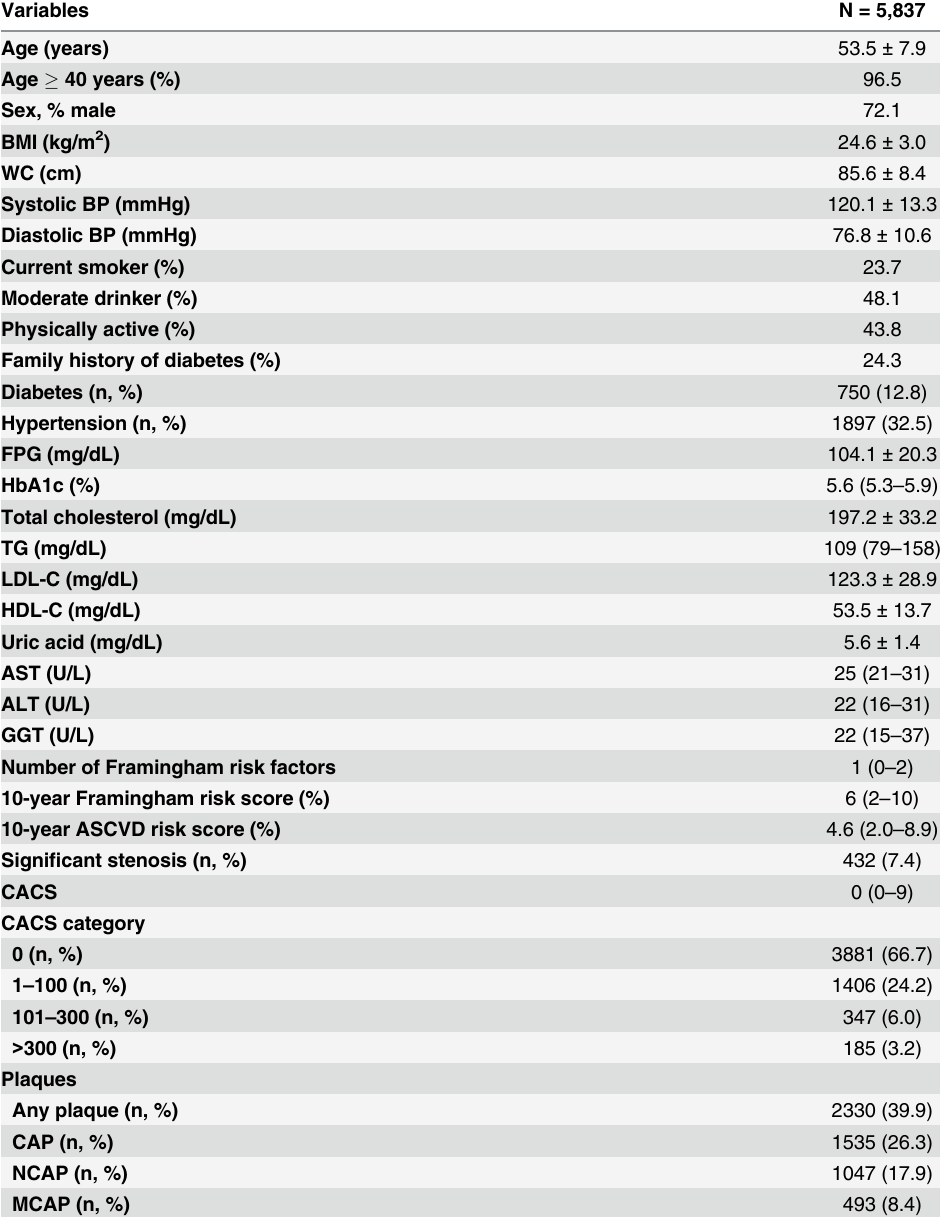
Table 1. Baseline demographic and clinical characteristics of all